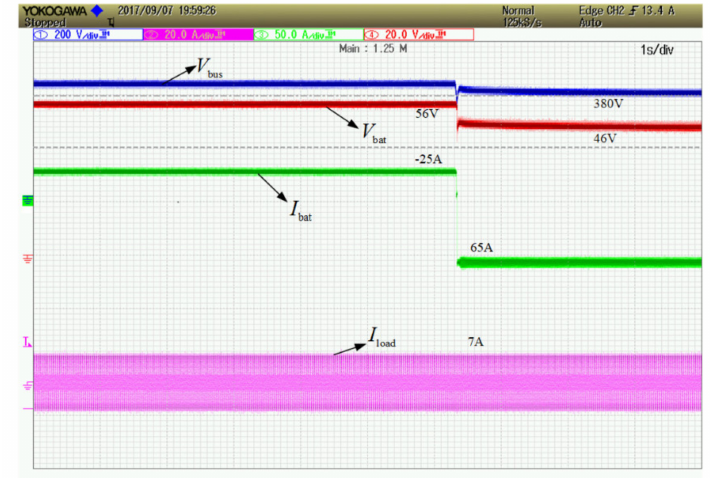
Figure 20. Experiment waveform of the converter from charging to discharging mode.